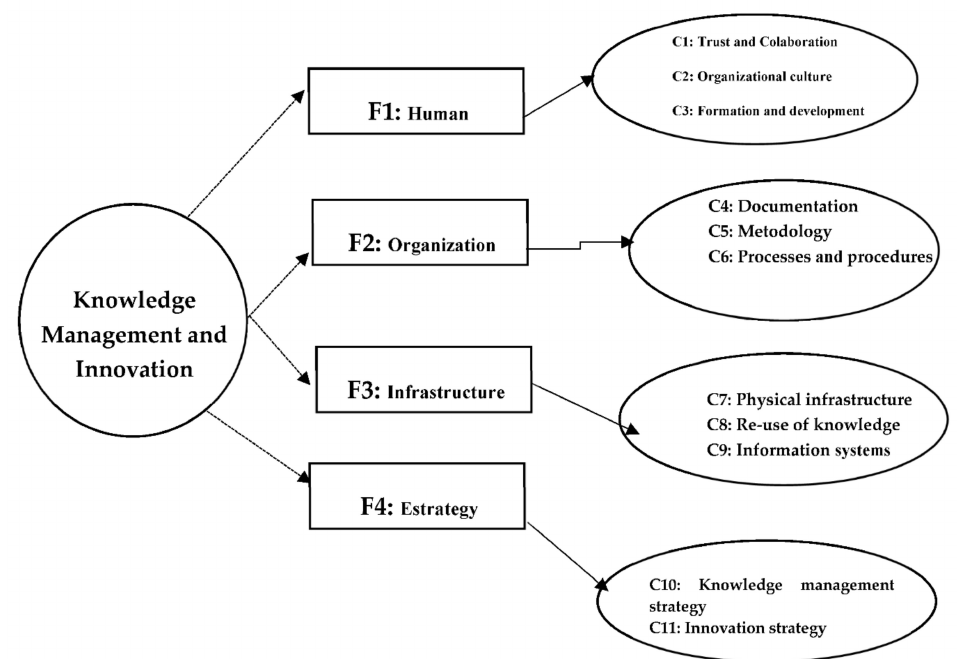
Figure 1. Proposed measurement